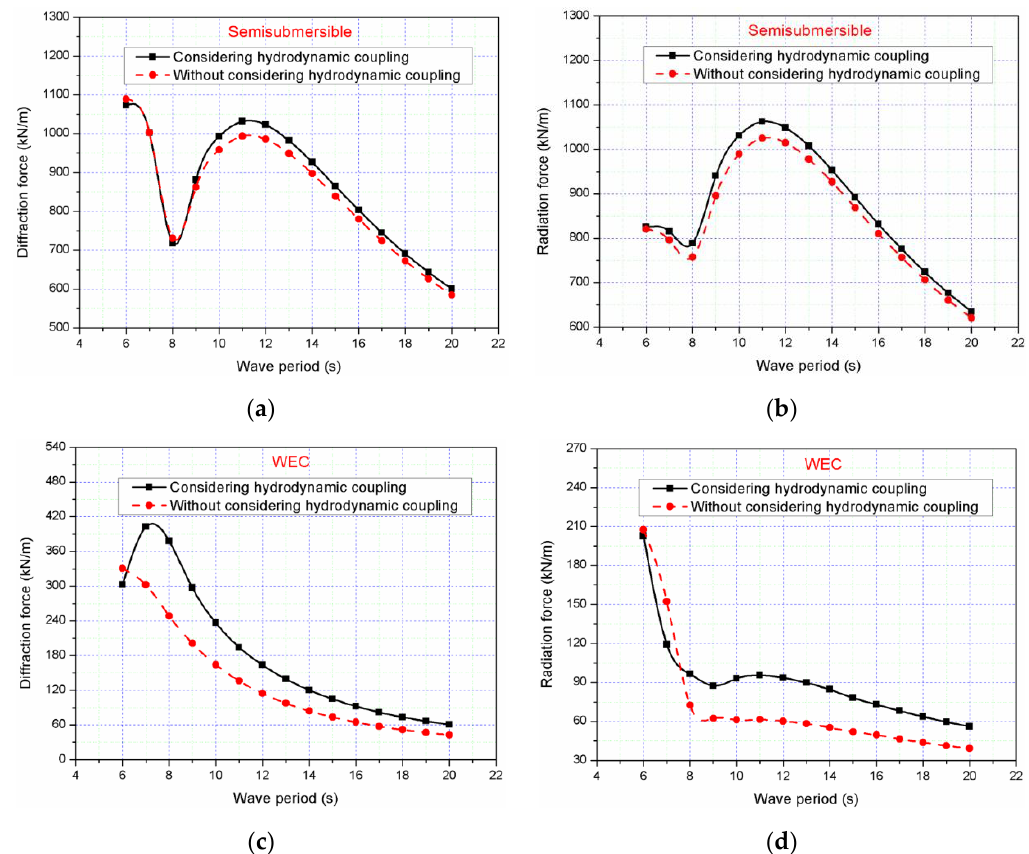
Figure 8. Comparison of diffraction forces and radiation forces of the combined structure between considering and without considering hydrodynamic coupling: ( a ) diffraction forces for semisubmersible; ( b ) radiation forces for semisubmersible; ( c ) diffraction forces for WEC; ( d ) radiation forces for WEC.